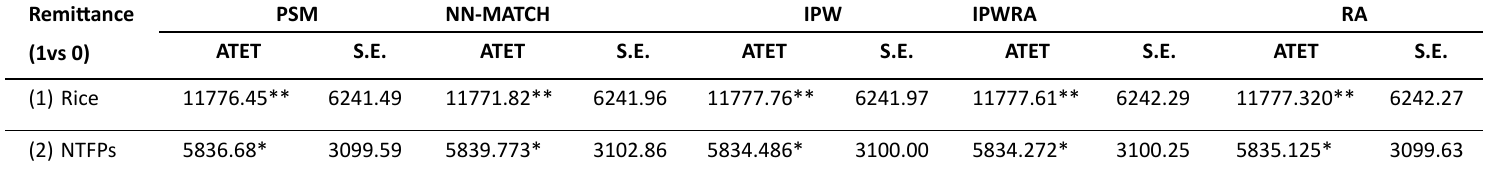
Table 10: ATET Estimation: Impact of Remittances on Investment